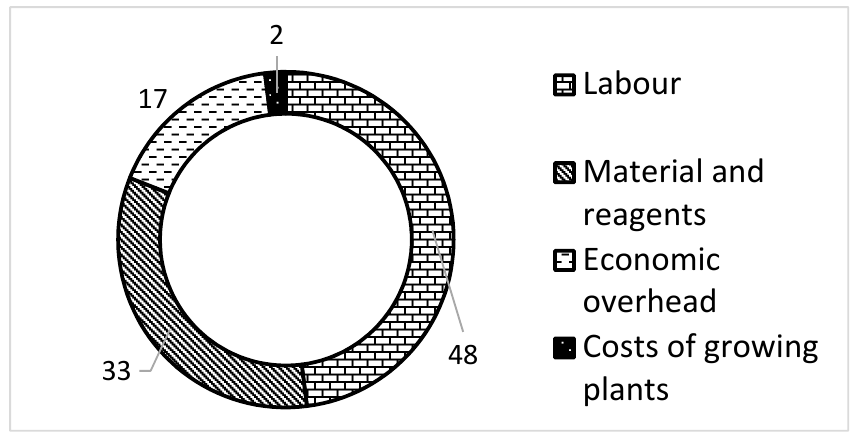
Figure 2. The costs for P. tomentosa × P. fortunei production in limited light conditions (%).